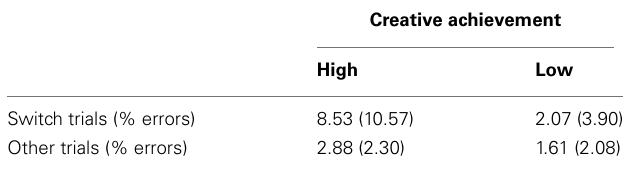
Table 1 | Experiment 1: mean (and SD) percent error rates on switch trials versus all other trials for high and low creative